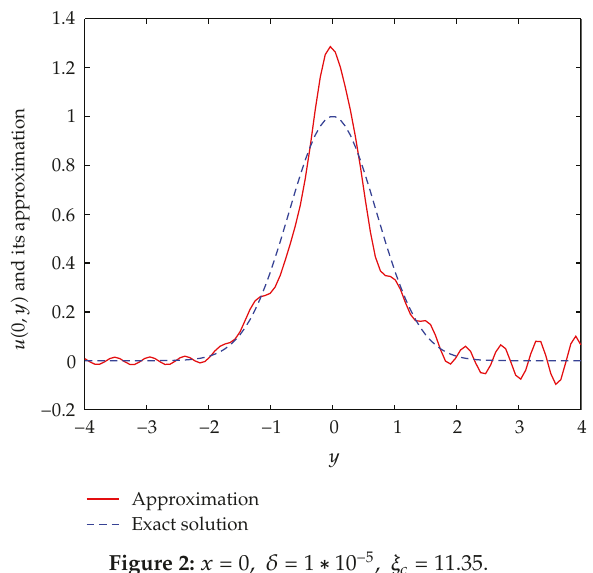
Figure 2: x (cid:2) 0 , δ (cid:2) 1 ∗ 10 − 5 , ξ c (cid:2) 11 . 35 .